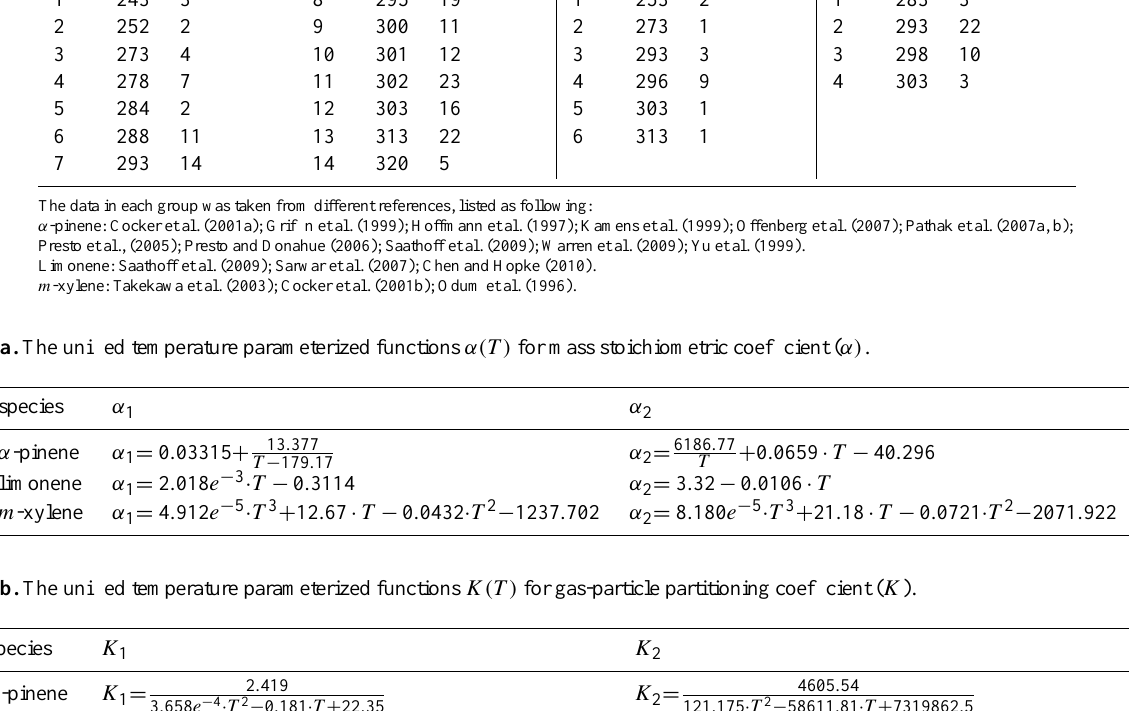
Table 2. Temperature grouping of the ozonolysis experiments of α -pinene and limonene, and photo-oxidation (OH initiated) experiments of m -xylene for deriving unified temperature parameterized functions for α and K . α -pinene Limonene m -xylene No. T Data points No. T Data points No. T Data points No. T Data points 1 243 3 8 295 19 1 253 2 283 252